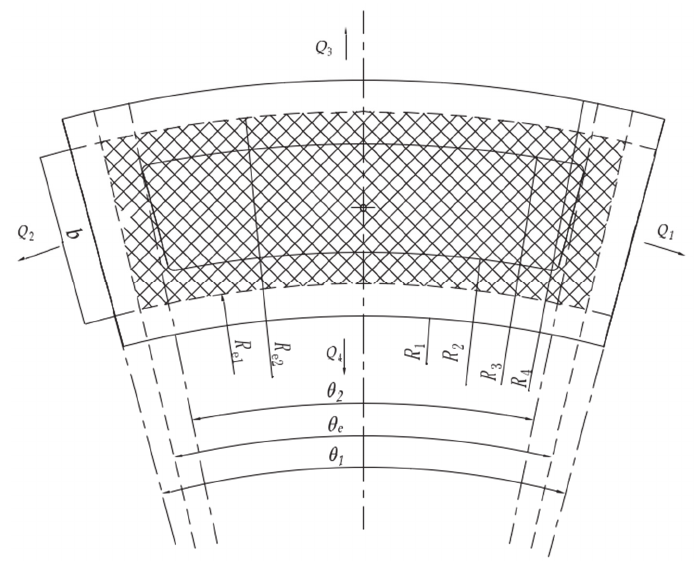
Figure 3. Schematic diagram of a single fan ‐ shaped flat oil pad. Length in the circumferential direction of the straight sealing edge (No. 1 and No. 2